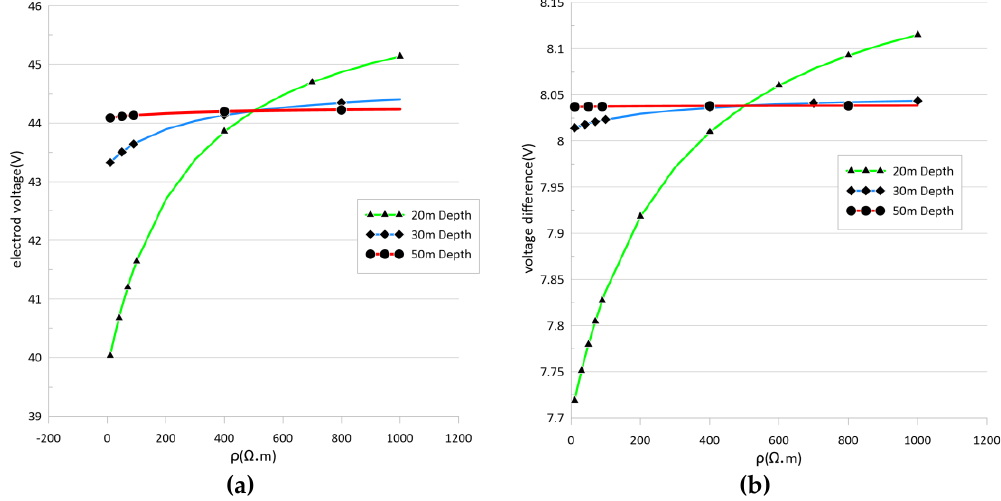
Figure 9. Variation curves of ( a ) electrode voltage and ( b ) voltage difference of different resistivity at different burial